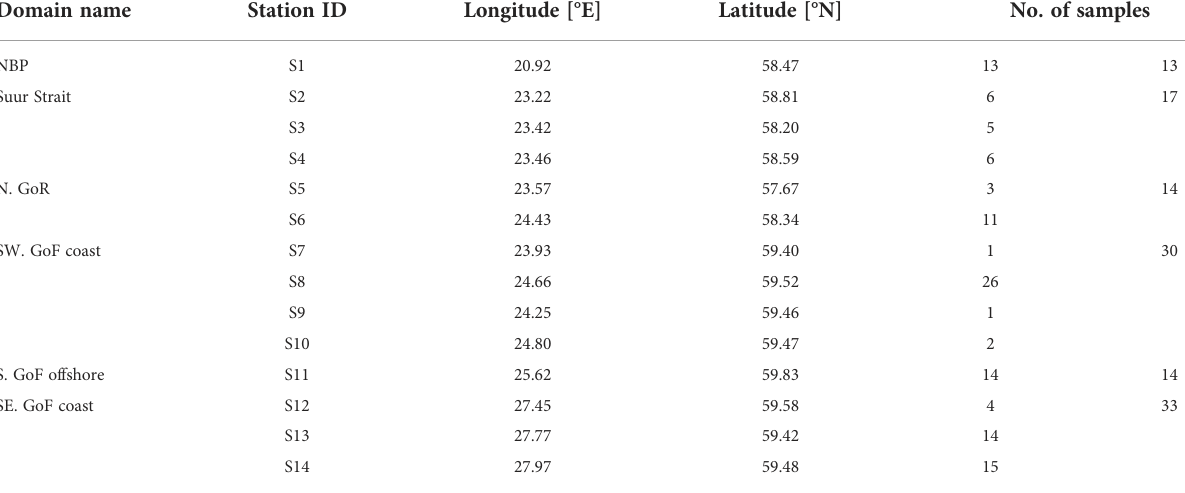
TABLE 2 The coverage and number of samples in the TalTech data set during April 2016 – August